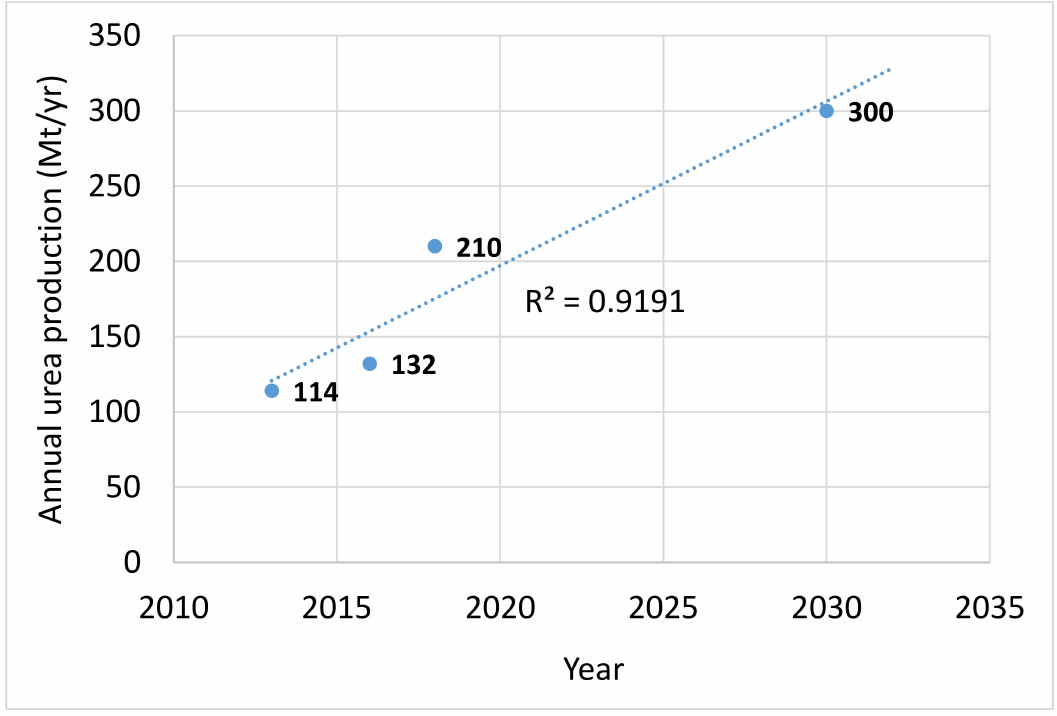
Figure 9. Growth in global urea production per annum, sources of data: Aresta et al. [61]; Statista